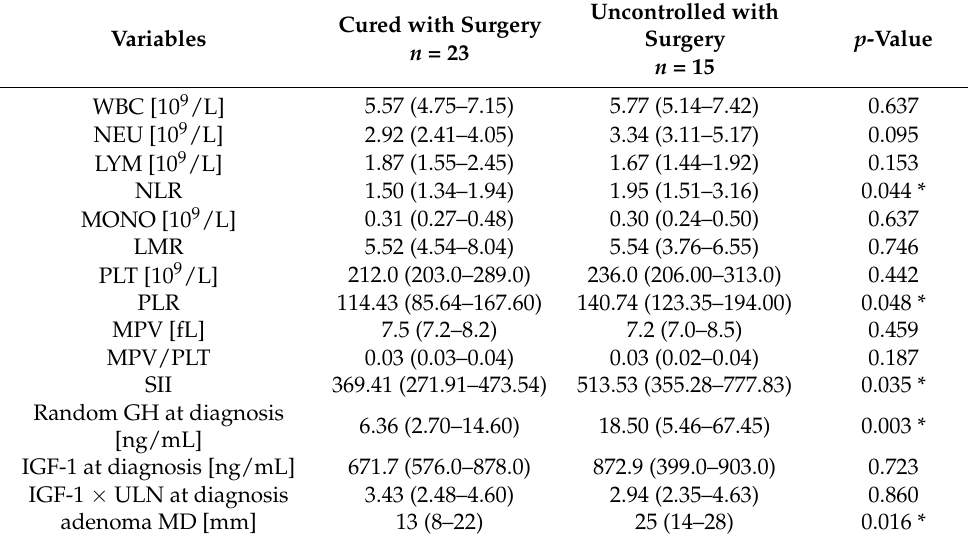
Table 4. Differences in initial values of CBC parameters and calculated ratios according to treatment effectiveness in patients with acromegaly who underwent surgical removal of pituitary